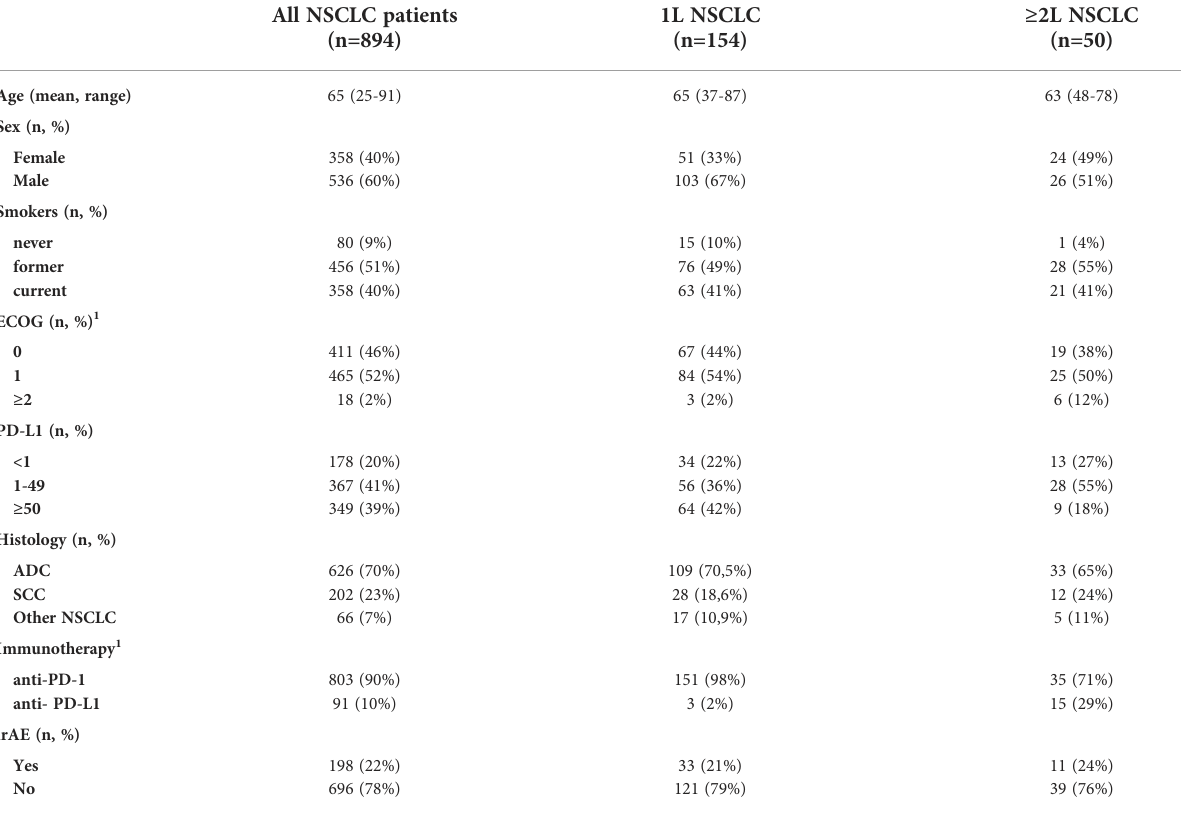
TABLE 1 Patient